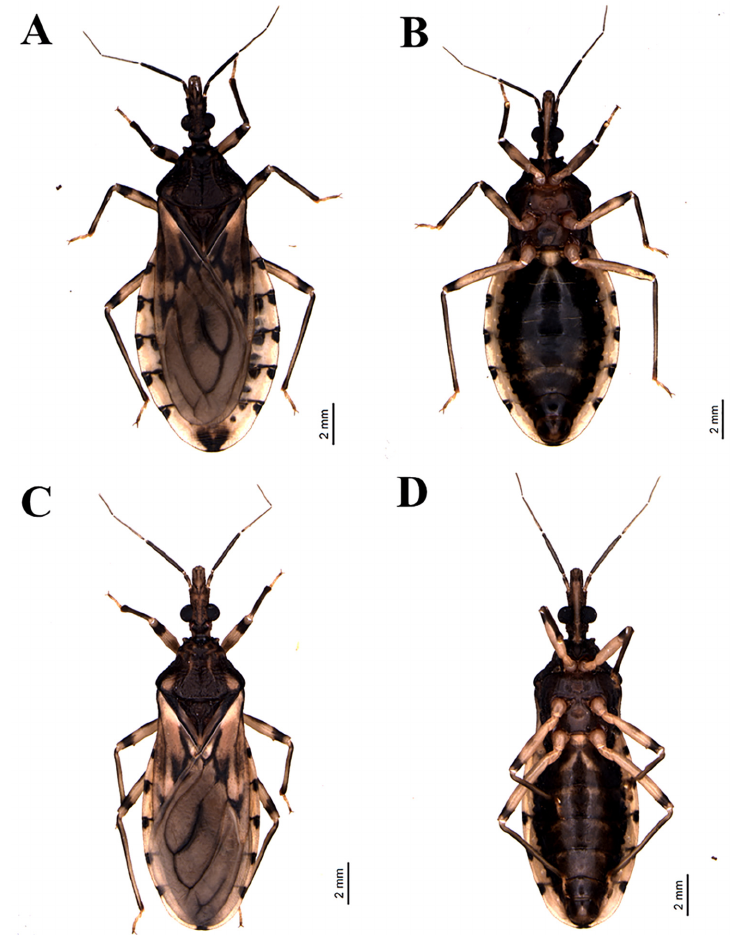
Figure 1. Triatoma rosai sp. nov. male ( A ) dorsal view, ( B ) ventral view, Triatoma sordida male ( C ) dorsal view, ( D ) ventral view.